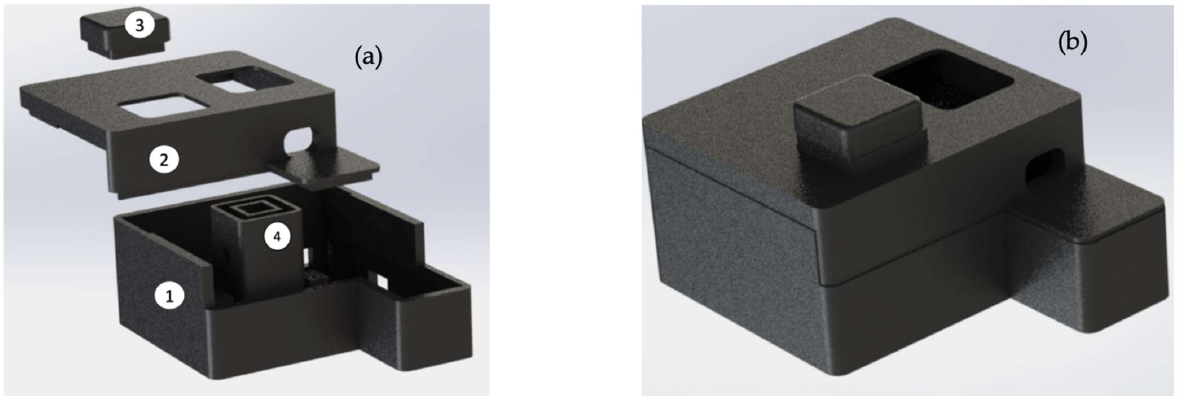
Figure 5. ( a ) Explosion view of 3D enclosure implemented to receive electronic components; ( b ) rendering of device closed for demonstration purposes.